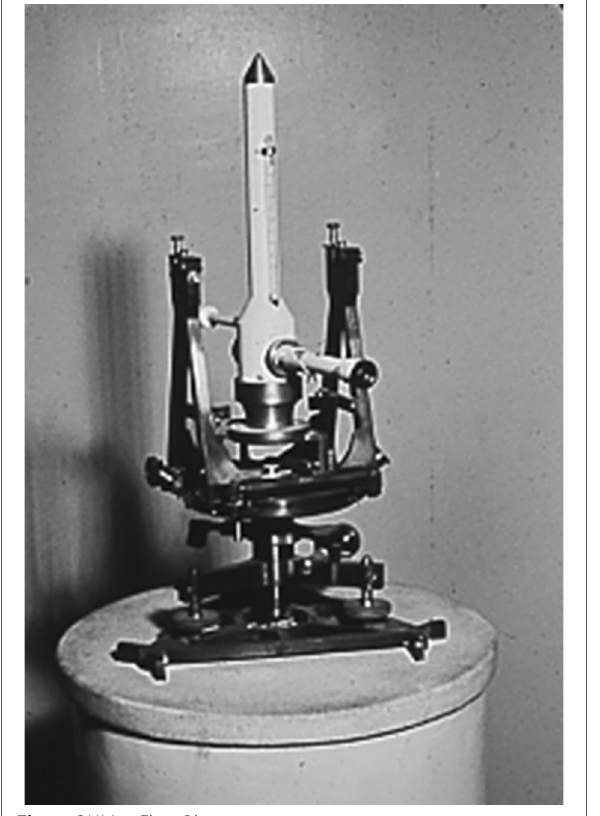
Fig. 5 QHM at Ebro Observatory